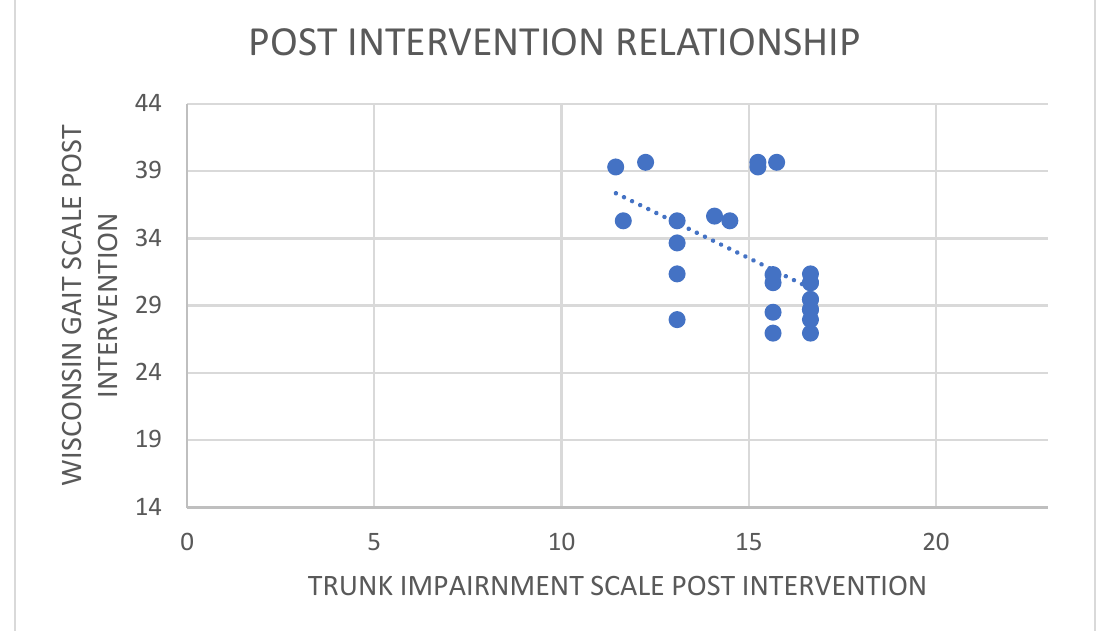
Figure 7. Relationship between post trunk impairment scale and post Wisconsin gait scale (moderate negative correlation).